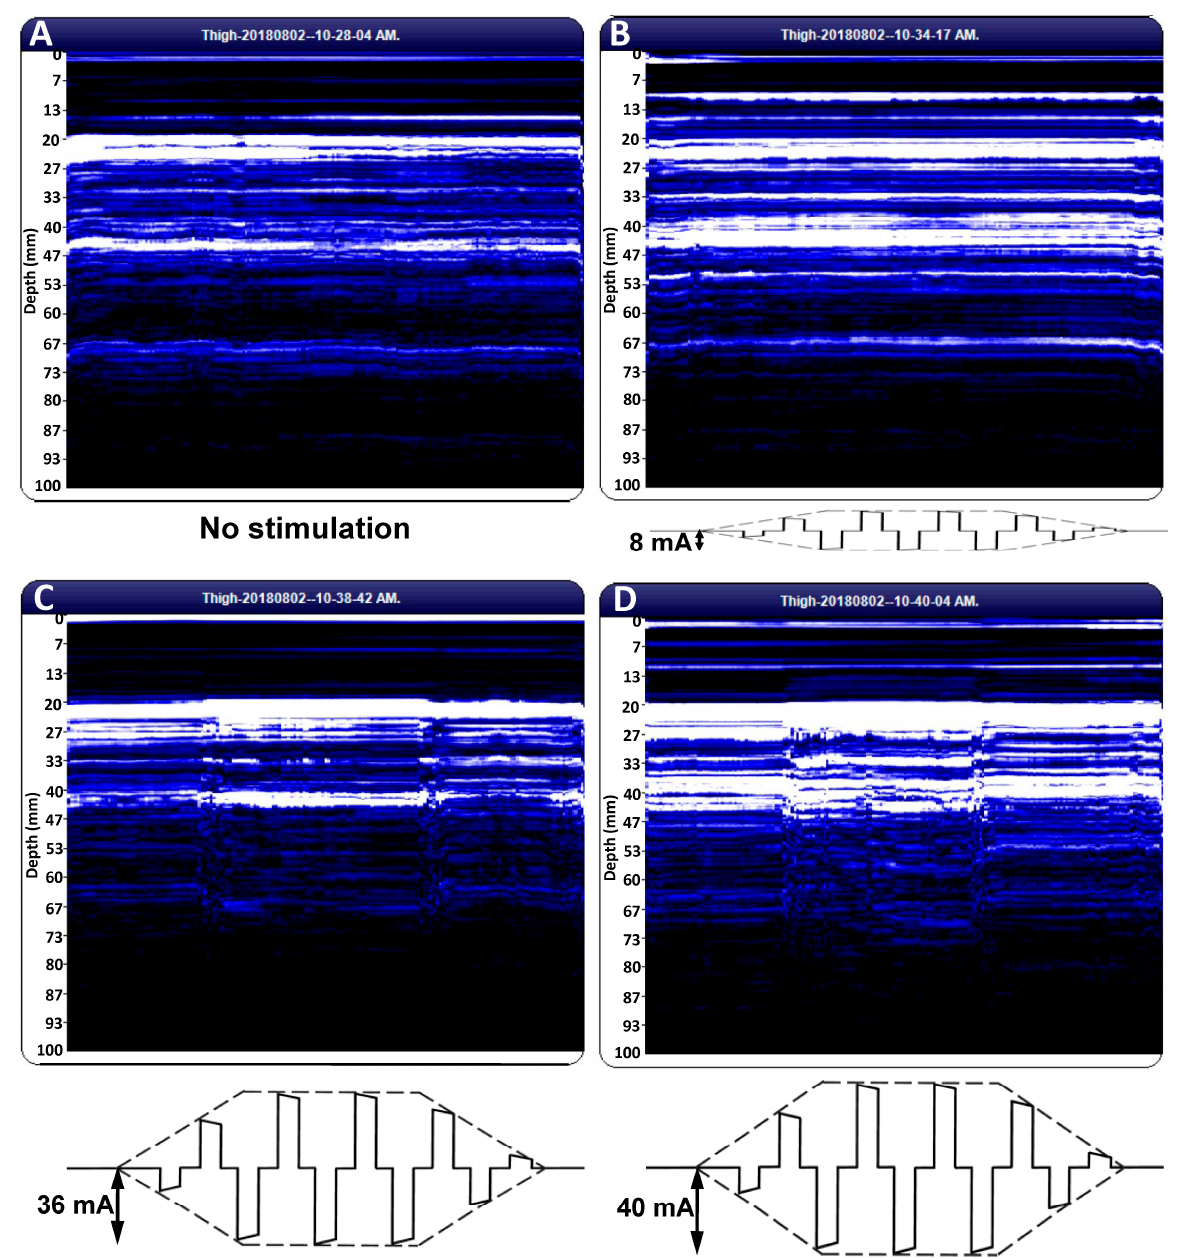
Figure 1. M-mode ultrasound (US) images acquired during neuromuscular electrical stimulation (NMES). US scans of the quadriceps muscle group recorded in the absence ( A ) and in the presence ( B – D ) of NMES, with the amplitude of the rectangular pulses set to the sensory threshold (ST) ( B ), the motor threshold (MT) ( C ), and 10% above the MT ( D ). During the scan, the US transducer was maintained in a steady position, midway between the NMES